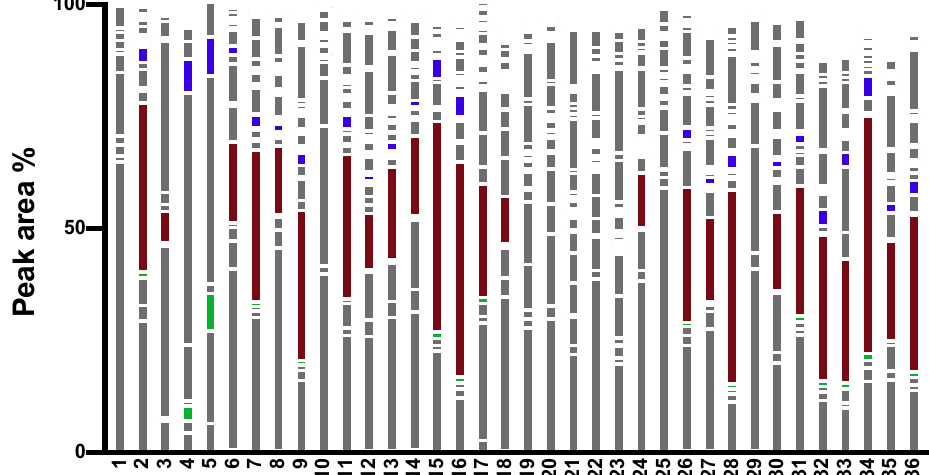
Figure 2. 3-carene-rich (red) and 3-carene-low EOs with terpinolene (blue) and sabinene (green).